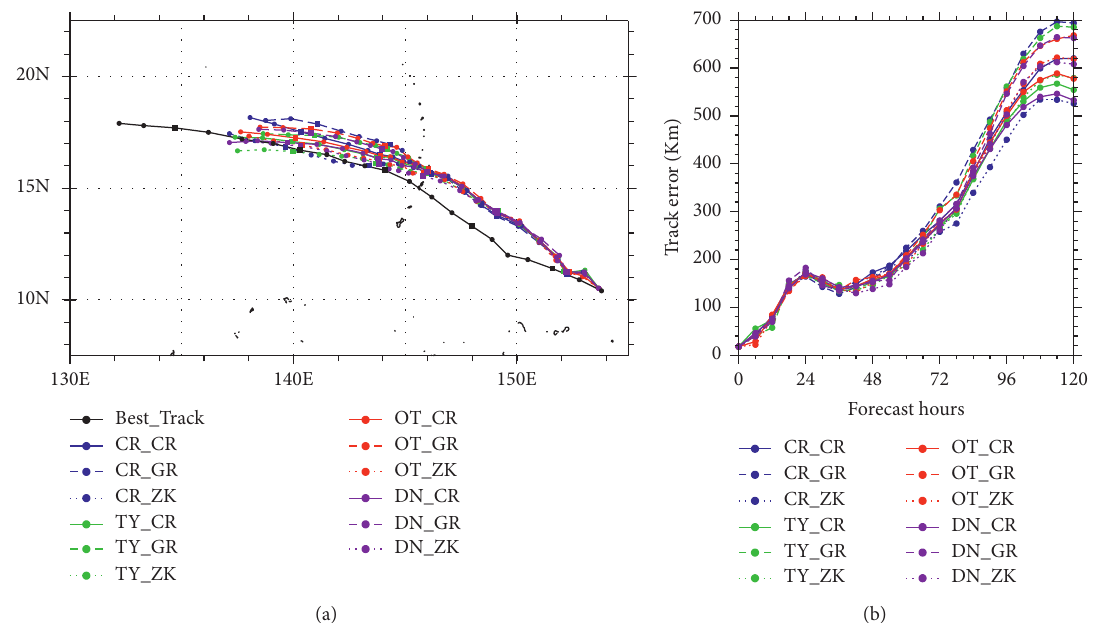
Figure 3: Simulated (a) tracks between 1200 UTC 22 Oct 2018 and 1200 UTC 27 Oct 2018 (positions at 0000 UTC are marked by squares) and (b) track errors from different